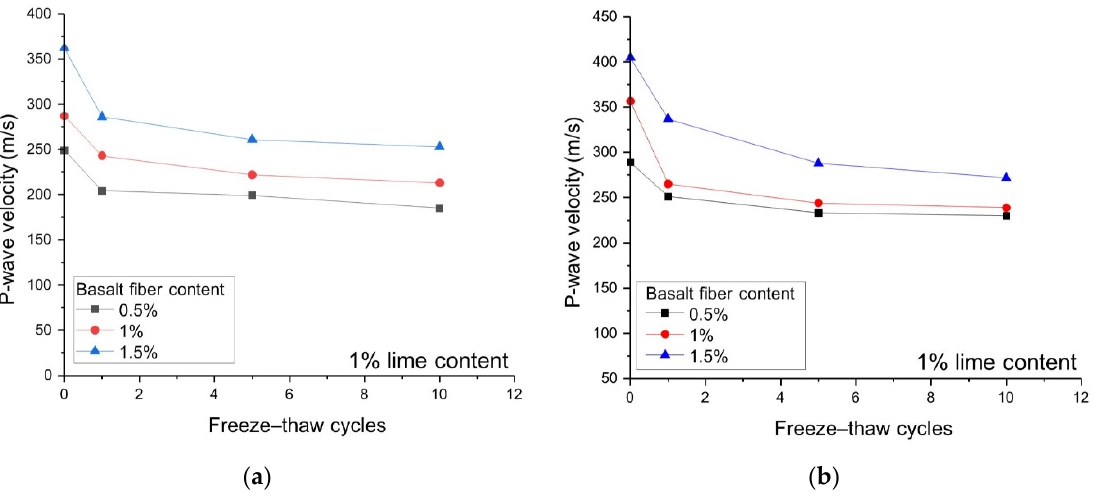
Figure 10. Effects of fiber content and length on the wave velocity with 1% lime content: ( a ) L = 6 mm and LC = 1%; ( b ) L = 12 mm and LC = 1%.